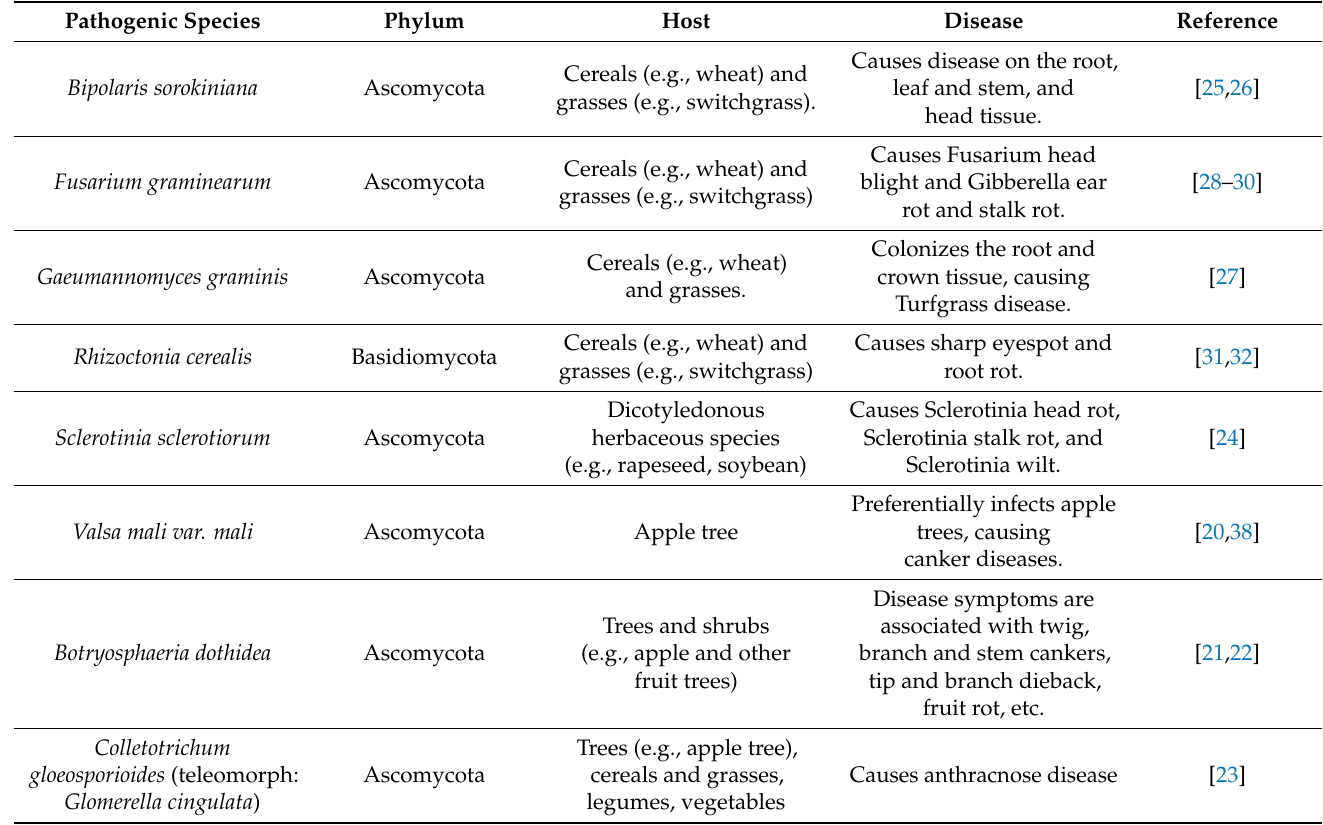
Table 1. Fungal pathogens used in this